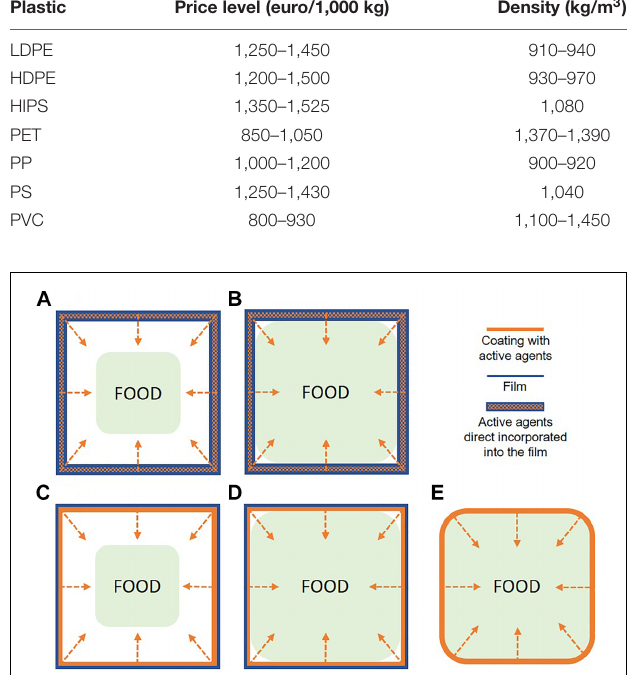
FIGURE 3 | Different ways of incorporation and release of antimicrobial agents into food: (A) direct incorporation into the film before extrusion and migration via gradual diffusion from the material into the headspace; (B) direct incorporation into the film before extrusion and migration via gradual diffusion from the material into the food through direct contact; (C) surface coating on the film and migration via gradual diffusion from the material into the headspace; (D) surface coating on the film and migration via gradual diffusion from the material into the food through direct contact; (E) edible film and migration via gradual diffusion from the material into the food through direct contact.